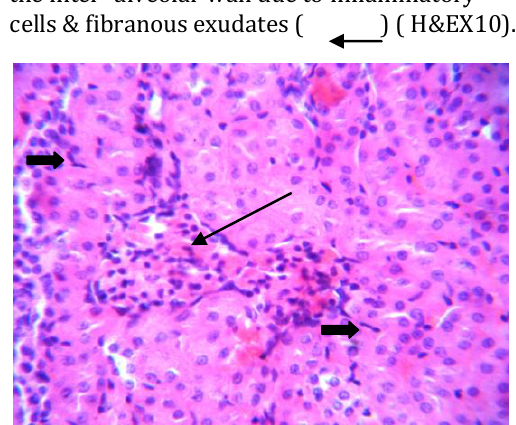
Fig (18): kidney at day 9 pi. showed inflammatory cells infiltration mainly lymphocyte between renal tubules ( ) in addition to atrophy of some glomerali ( ) ( H&EX10).